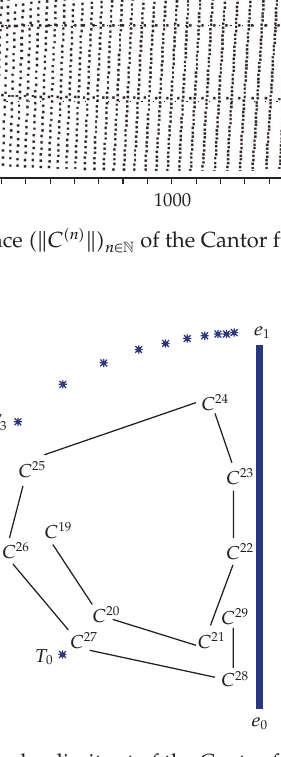
Figure 6: Orbit and ω -limit set of the Cantor function C